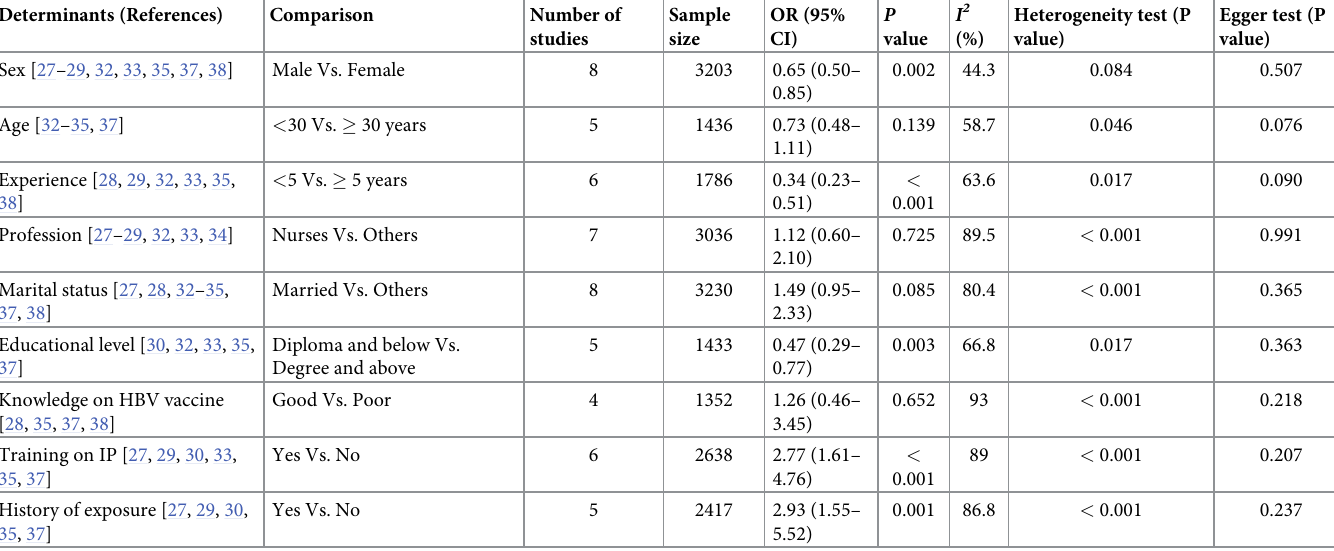
Table 4. Factors associated with full-dose hepatitis B vaccination coverage among health care workers in